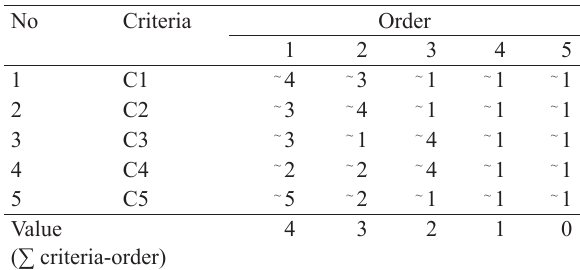
Table 5 Comparison scale of determination of the fuzzy-TOPSIS method alternative